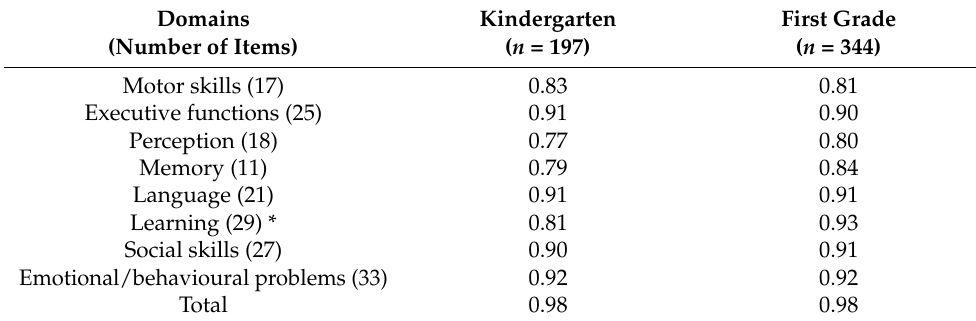
Table 3. Reliability by Domains of the FTF Questionnaire in the Current